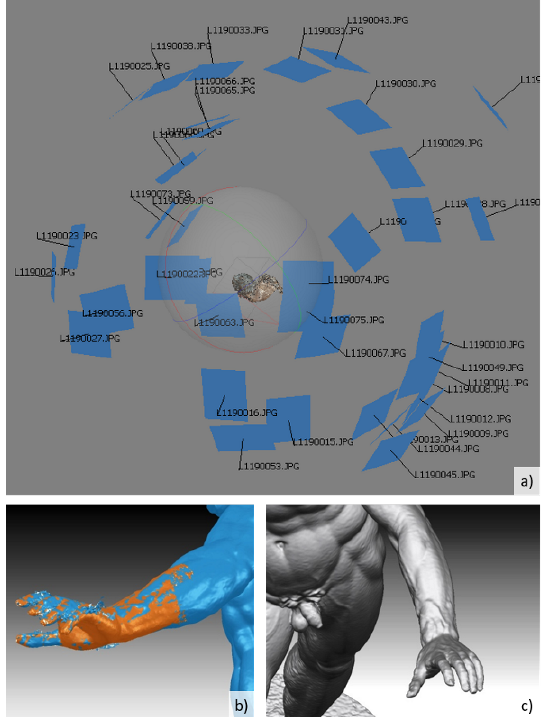
Figure 7. 3D modelling of the left hand by SfM (a); alignment between the model by SfM, in orange and the one by scanning, in blue (b); the two merged models (c).